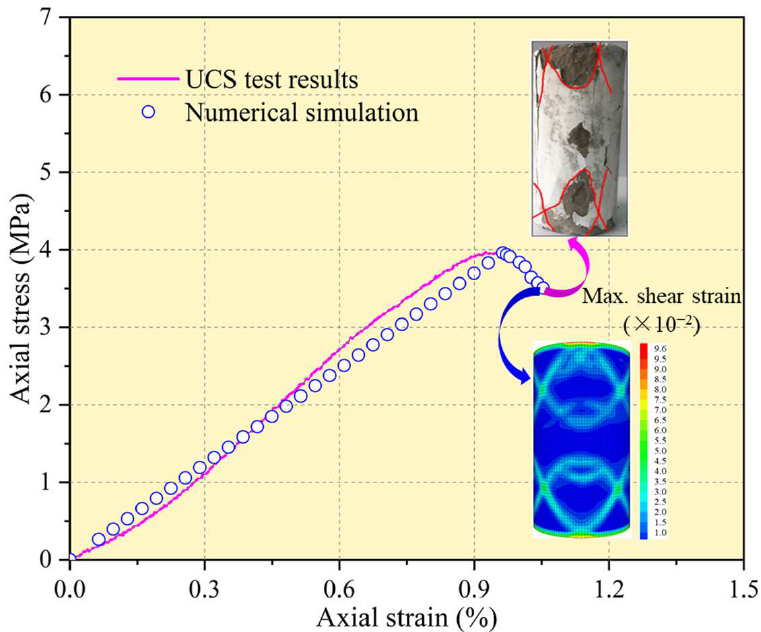
Figure 11. The stress–strain curves and failure model of CMFB from the laboratory UCS test and the numerical simulation.